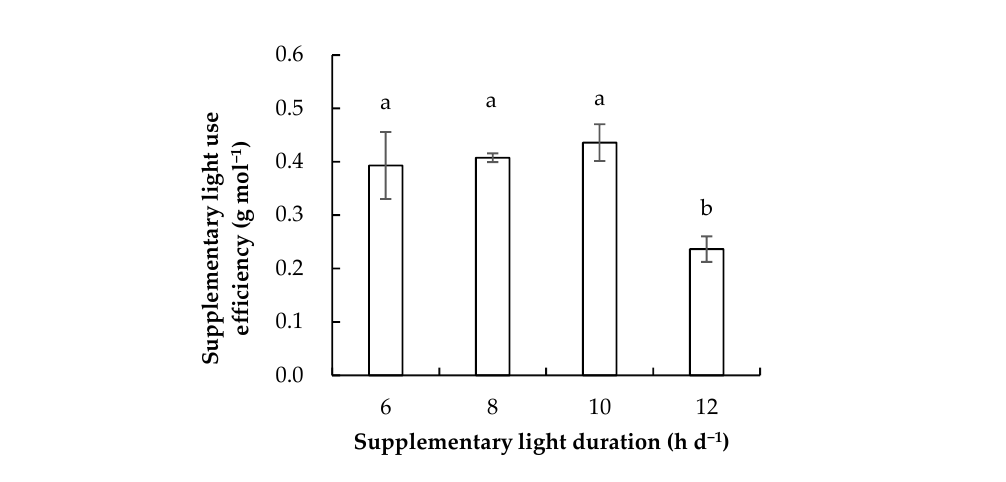
Figure 6. Supplementary light use efficiency of cucumber seedlings grown with light duration at 6, 8, 10, and 12 h d − 1 with the same daily light integral in the greenhouse for 21 days after sowing. Means followed by different letters within each parameter are significantly different based on the least significant difference (LSD) test ( p < 0.05). Error bars show ± standard deviation.